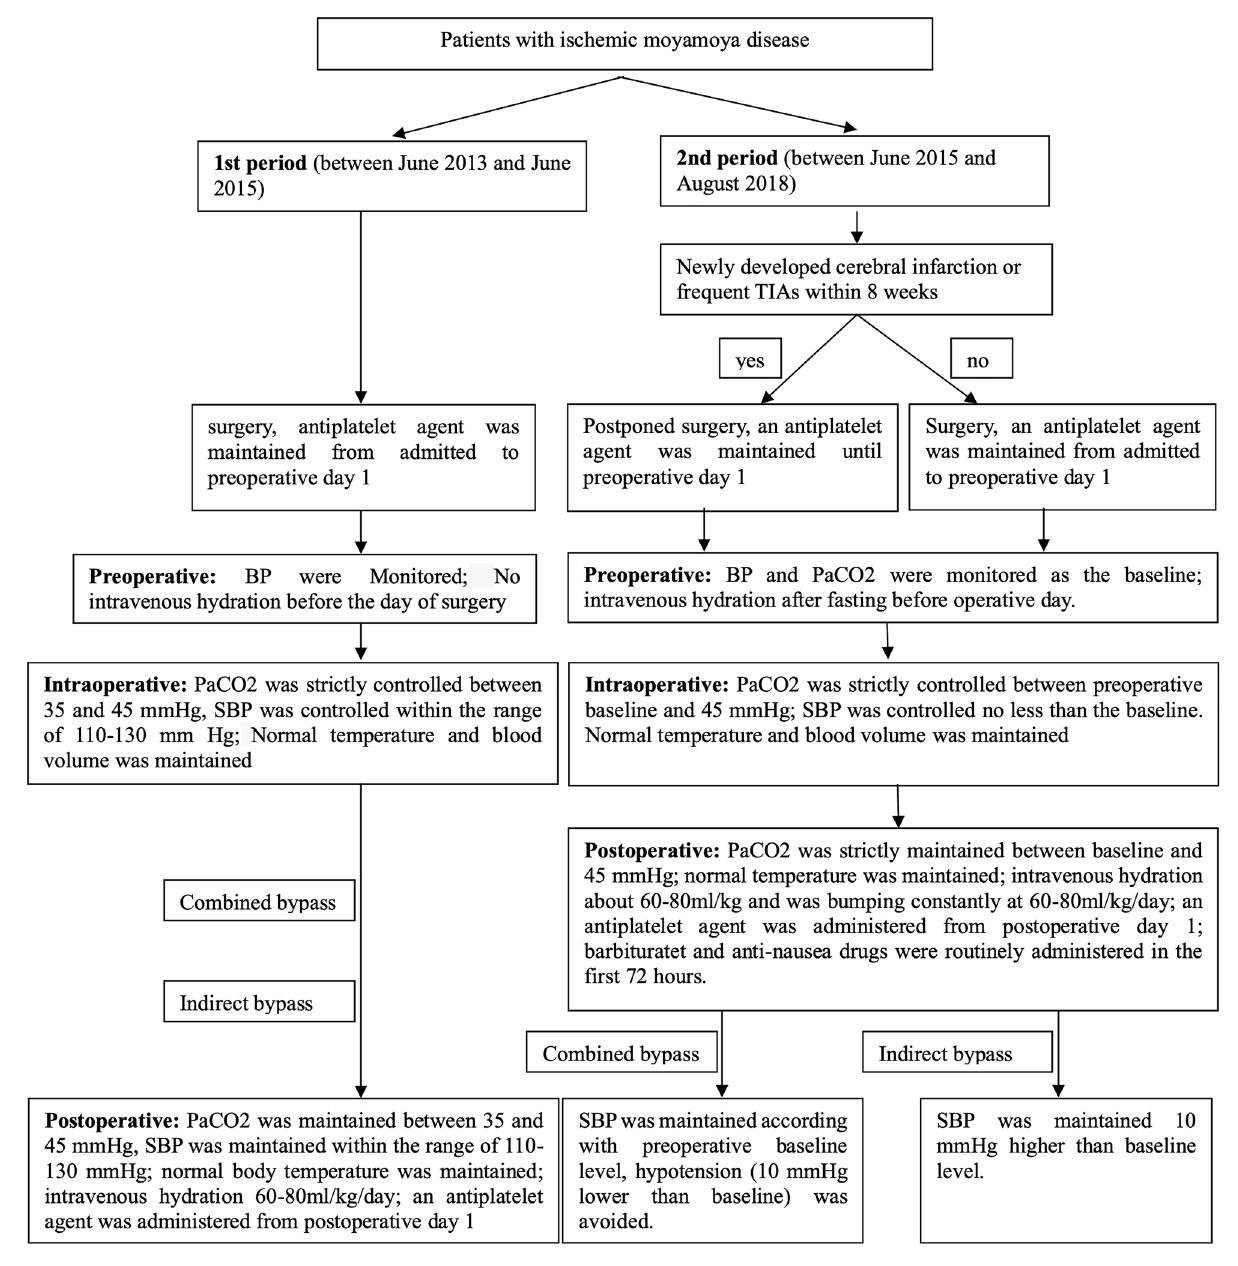
Figure 2. Protocol tree of perioperative management of patients with ischemic Moyamoya disease. BP: Blood pressure.